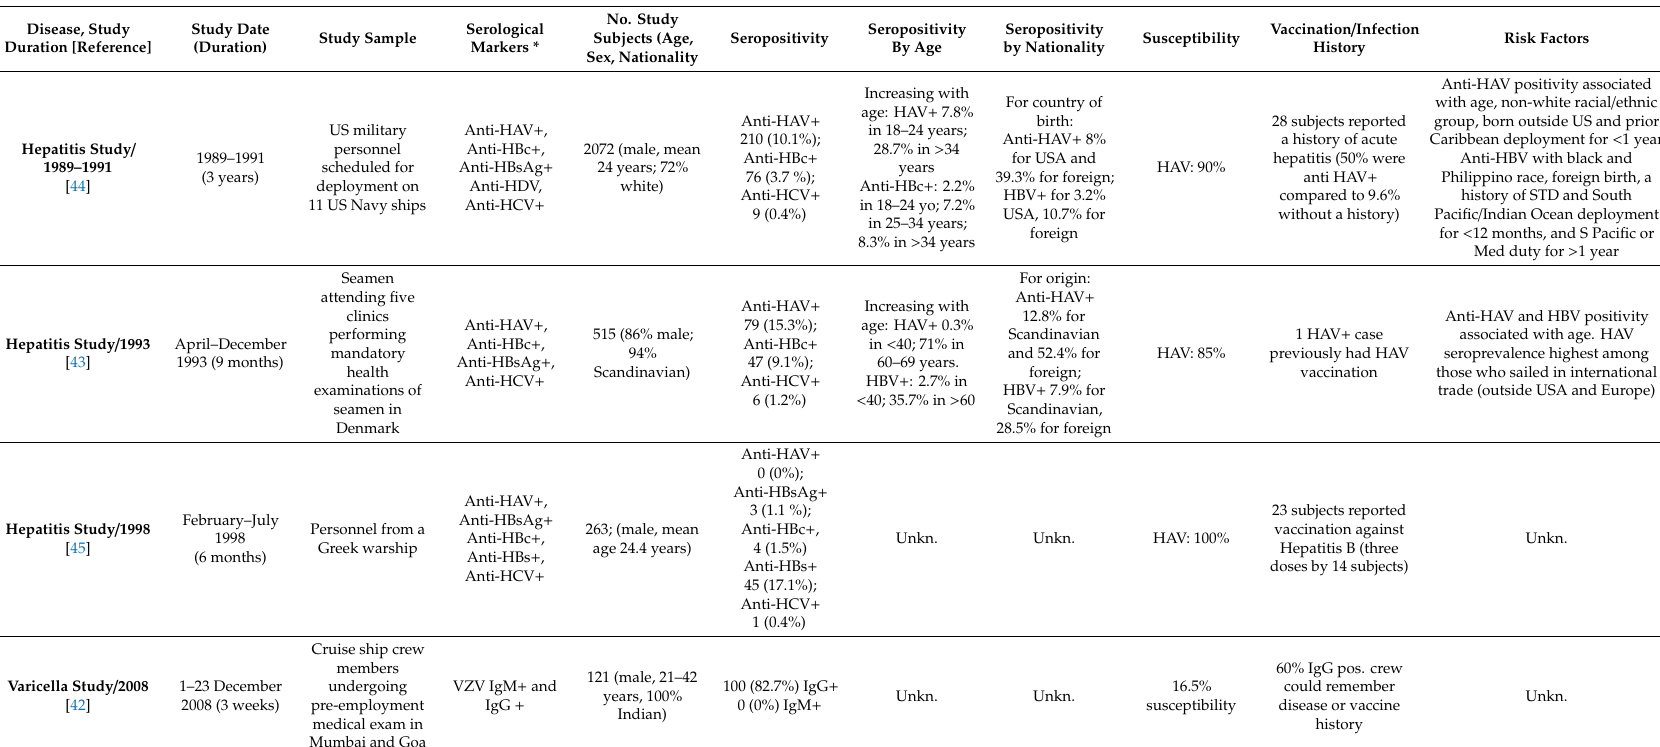
Table 3. Seroprevalence